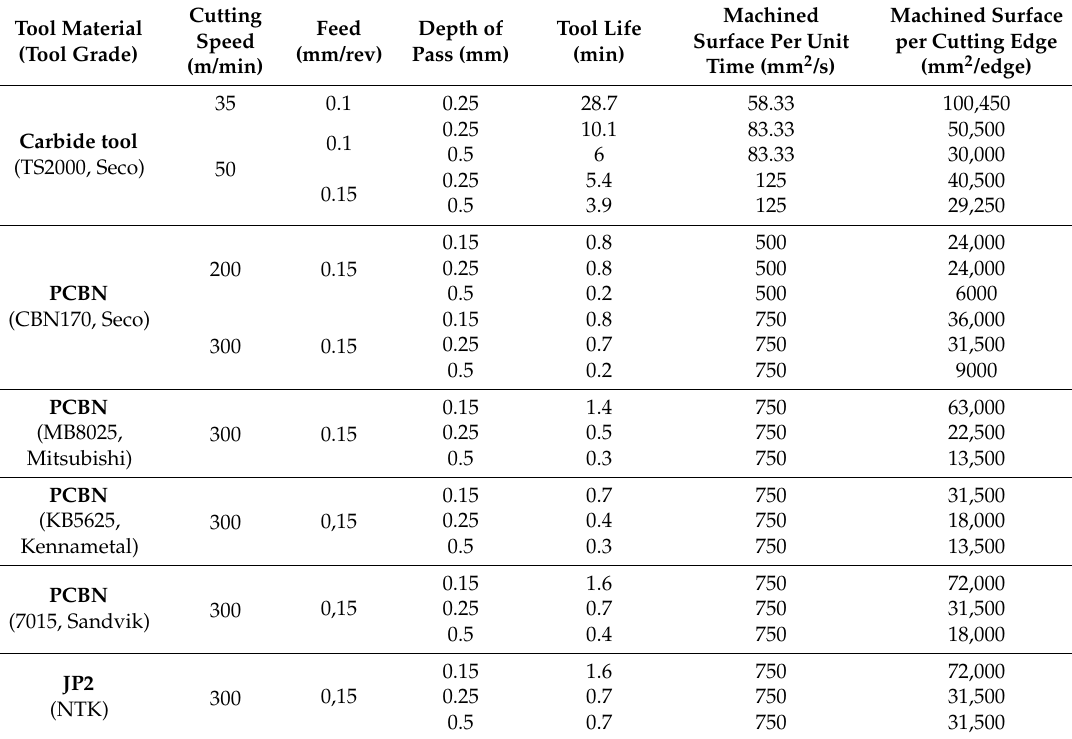
Table 4. Results of tool life and machined surface per cutting edge for all tests